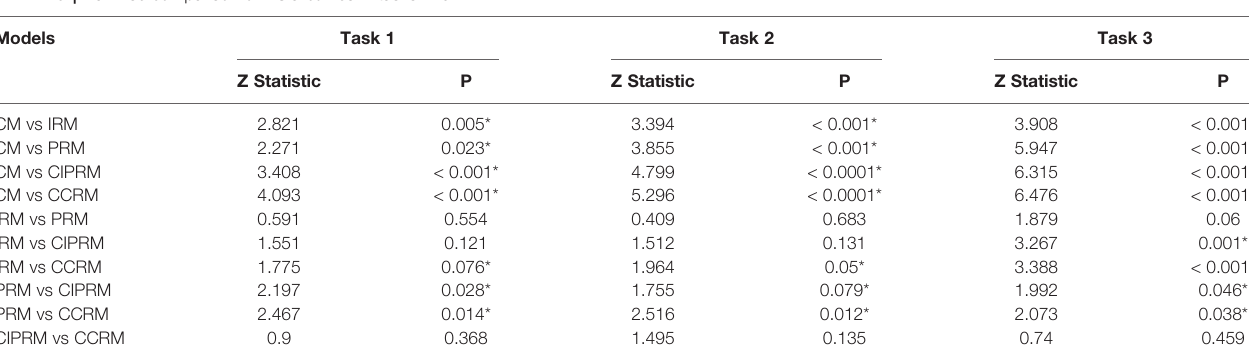
TABLE 3 | Pairwise comparison of ROC curves in tasks 1 – 3.